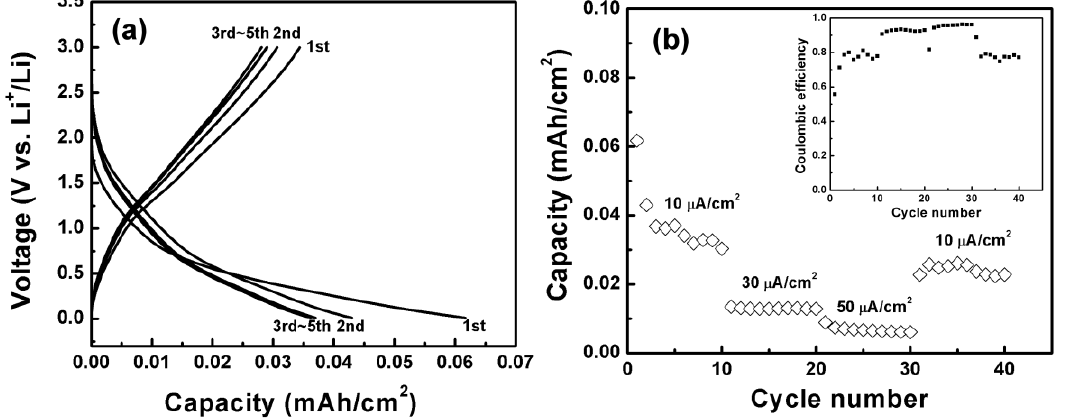
Figure 4. Charge-discharge curves of coal char derived graphene anode at 10 µA/cm 2 between 3.00 V and 0.01 V vs Li/Li + ( a ). Discharge capacity vs. cycle numbers at different current densities (10, 30, and 50 µA/cm 2 ), ( b ). Inset: the corresponding coulombic efficiencies vs. cycle